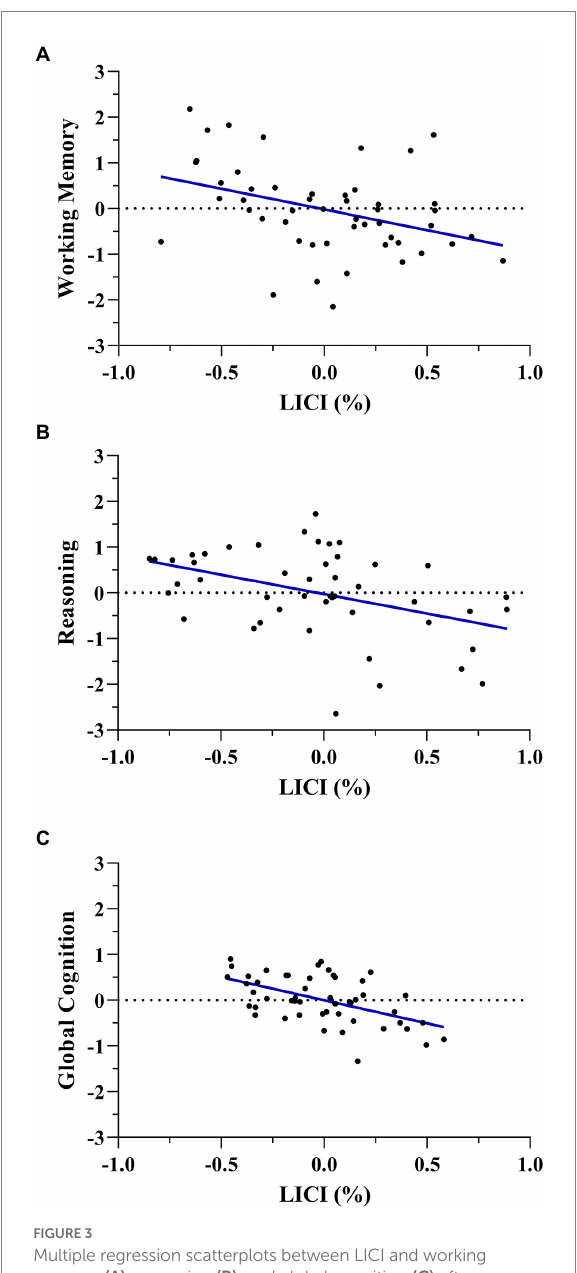
FIGURE 3 Multiple regression scatterplots between LICI and working memory (A) , reasoning (B) , and global cognition (C) after controlling age and years of education in men. Z-scores were used on the Y-axis and unstandardized Predicted Values on the X-axis